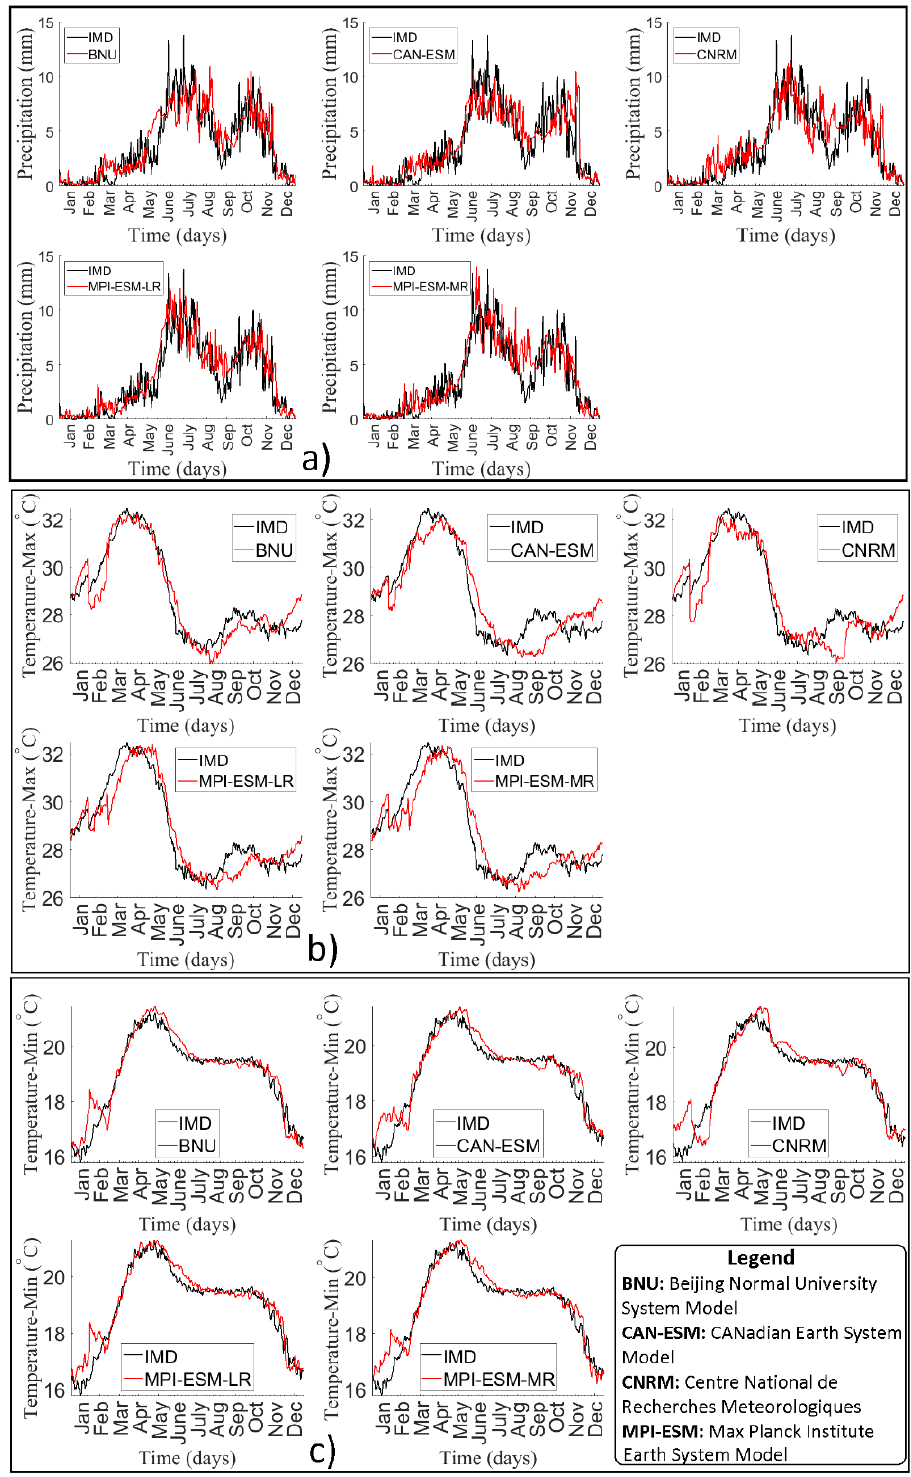
Figure 4. GCMs climatology (red), compared with observed climatology (black) for monthly: ( a ) rainfall (top); ( b ) maximum temperature, (middle), and ( c ) minimum temperature (bottom) from 1981 to 2010.